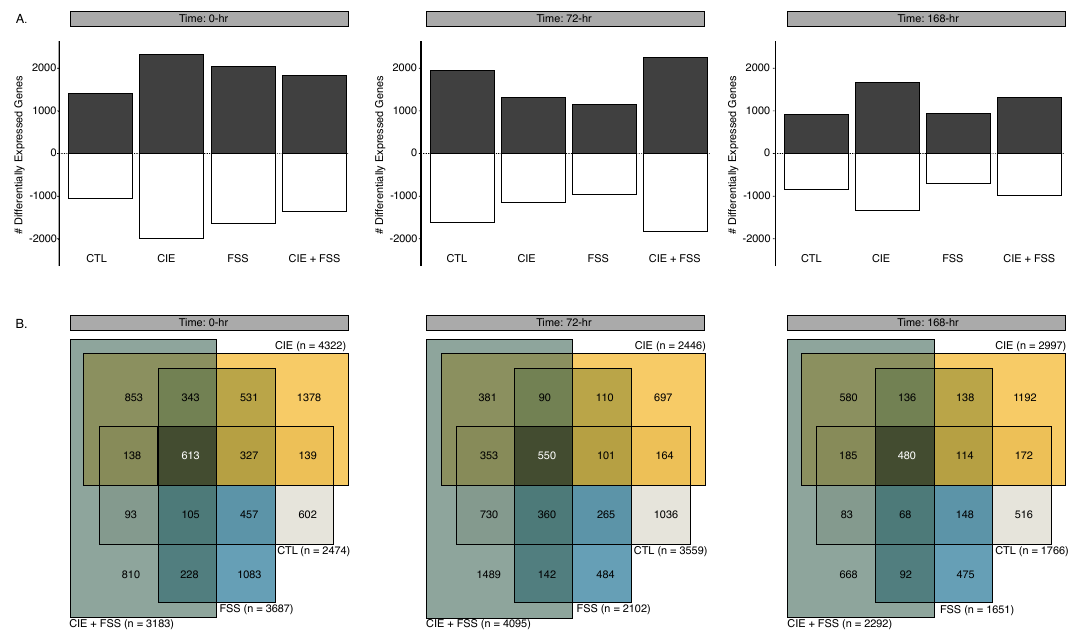
Figure 4. Summary of di ff erential gene expression results for the medial prefrontal cortex (CTX) based on comparison to naïve subjects. ( A ) Bar plots of the number of di ff erentially expressed genes at timepoints 0 h, 72 h, and 168 h. Increased gene expression shown in dark grey, and decreased gene expression shown in white. ( B ) Venn-diagrams showing the four-way overlap of all di ff erentially expressed genes for timepoints 0 h, 72 h, and 168 h. Each of the respective behavioral groups are indicated by a di ff erent color: CTL = light grey, CIE = yellow, FSS = blue, and CIE + FSS = green.